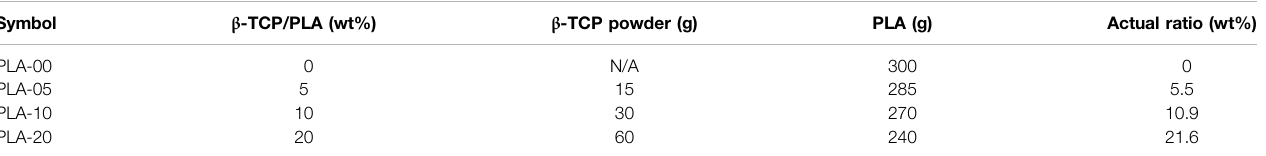
TABLE 1 | PLA/ β -TCP fi lament weight ratio percentages achieved. Symbol